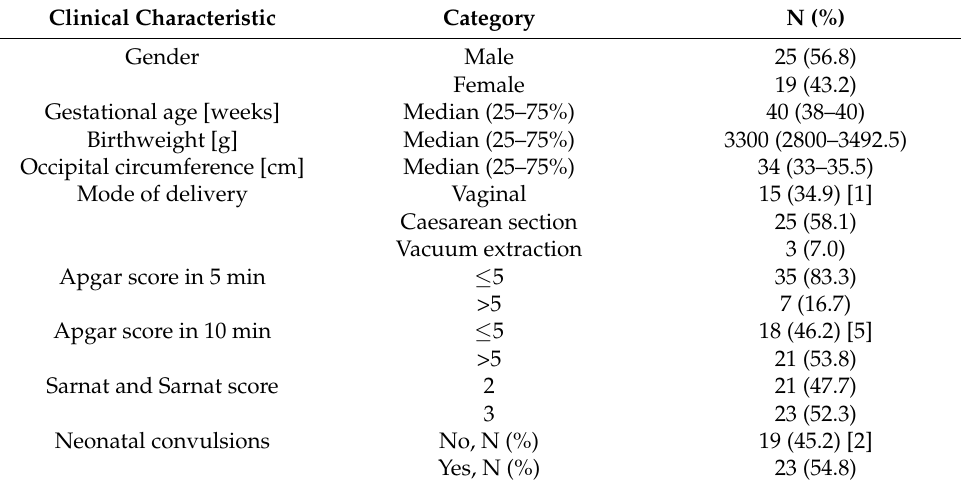
Table 1. Clinical characteristics of 44 newborns with HIE.